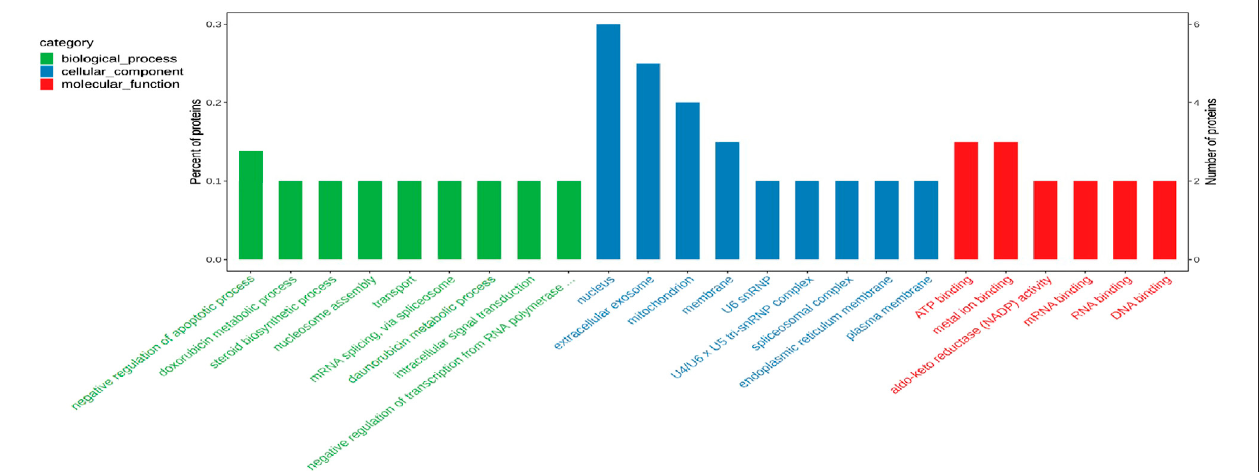
FIGURE 8 | Gene ontology (GO) enrichment analysis of 29 common differentially expressed proteins.